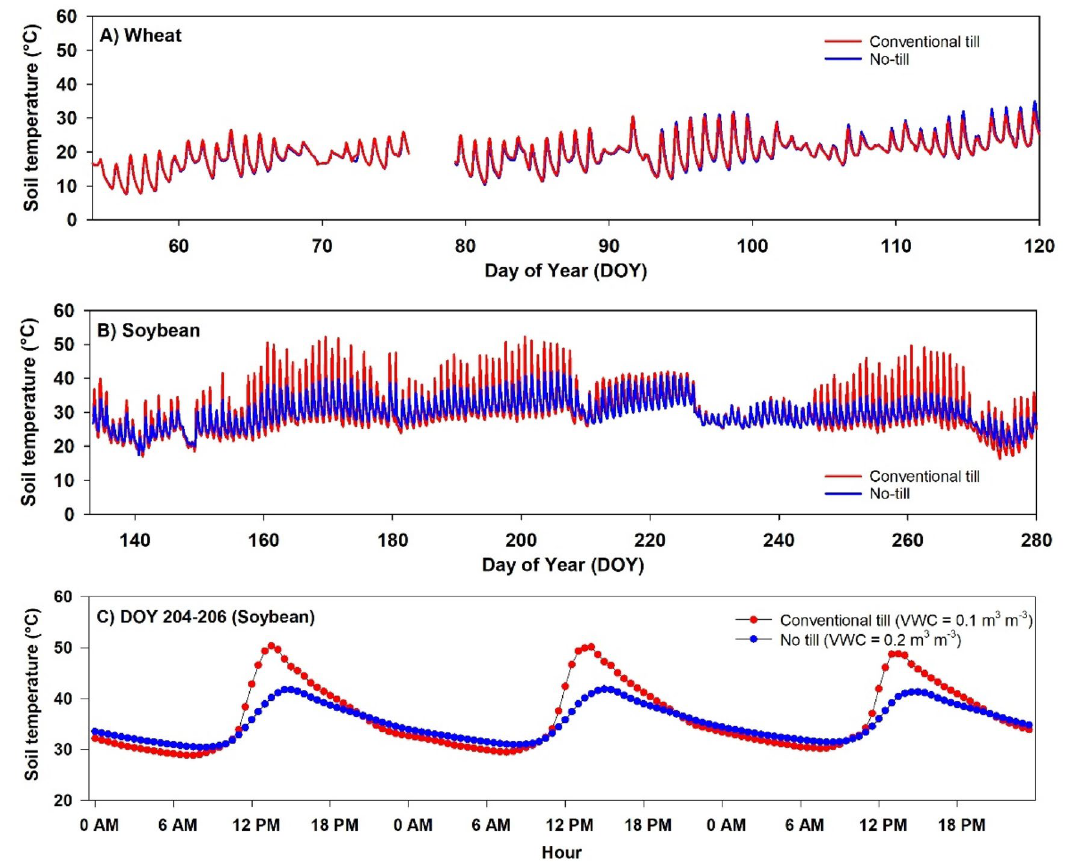
Figure 2. Soil temperature measured at 5 cm depth in (A) wheat, (B) soybean, and (C) for three consecutive days (DOY 204–206) in soybean plots under conventional tillage and